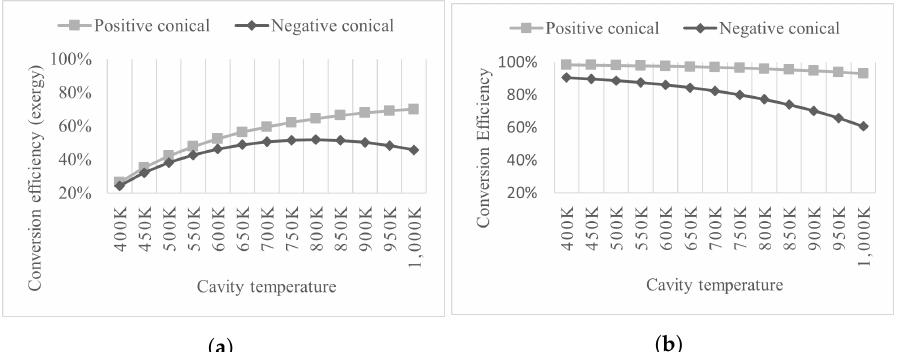
Figure 6. Cavity efficiency results in analytical investigation: ( a ) Cavity exergy conversion efficiency; ( b ) Cavity energy conversion